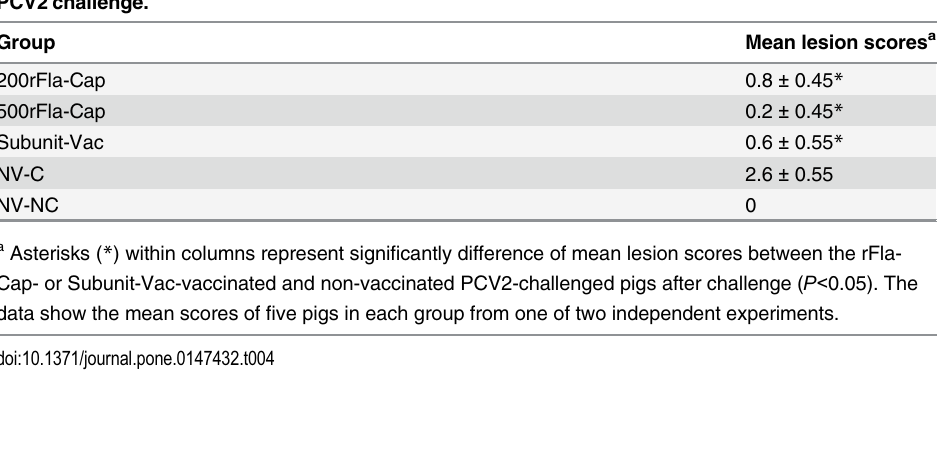
Table 4. Histopathological lesion scores for inguinal lymph nodes of rFla-Cap vaccinated pigs after PCV2 challenge. Group